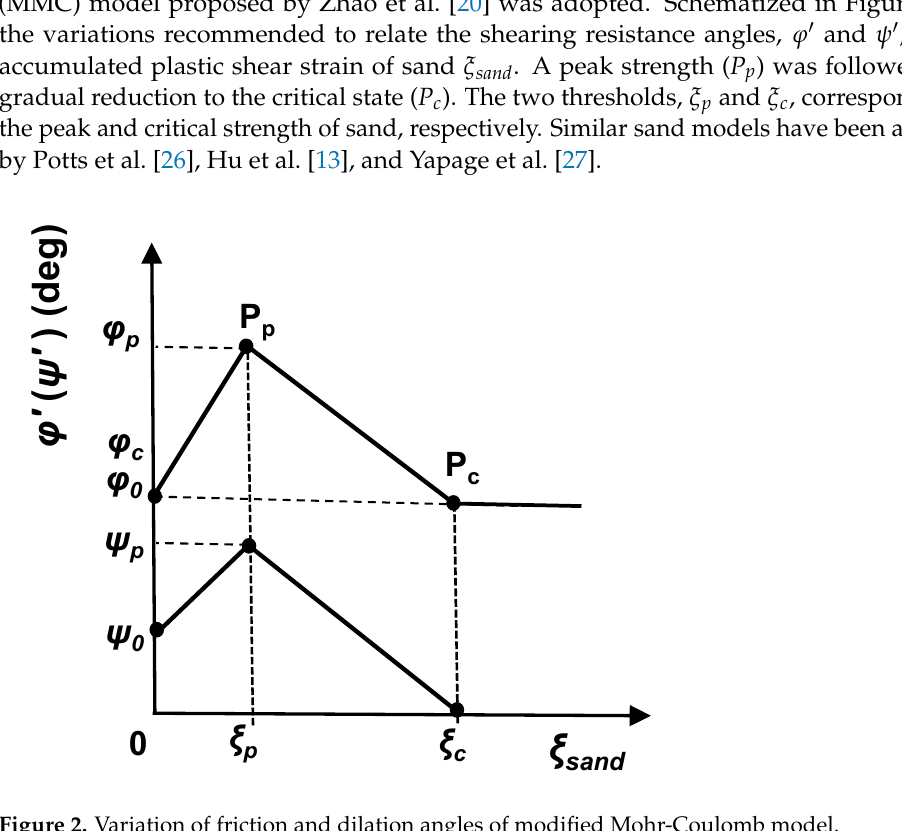
Figure 2. Variation of friction and dilation angles of modified Mohr-Coulomb model.